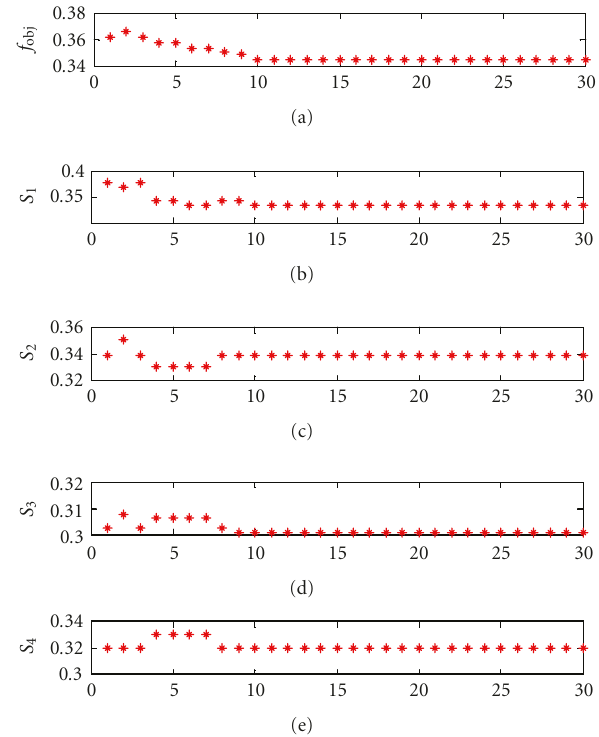
Figure 9: f obj , S 1 , S 2 , S 3 , and S 4 from GA optimization process (Rock1).